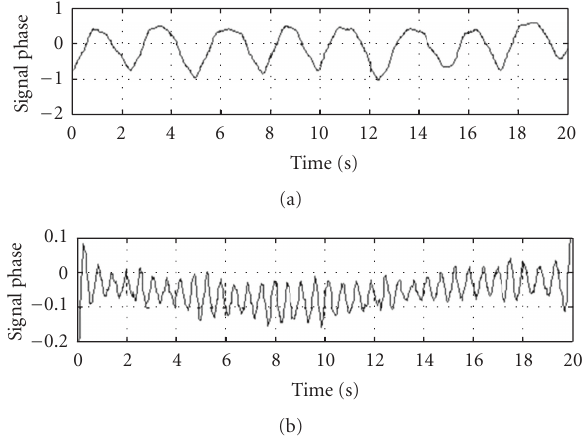
Figure 3: Reconstructed breathing (a) and heartbeat (b) signals of the examinee corresponding to the range-frequency matrices from Figure 2. The signal phase is normalized with respect to its maxi-